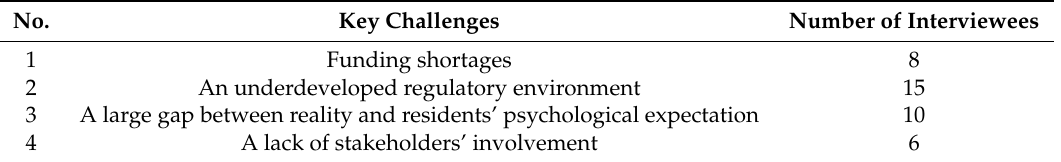
Table 5. Key challenges in Shanghai’s transition from HD to